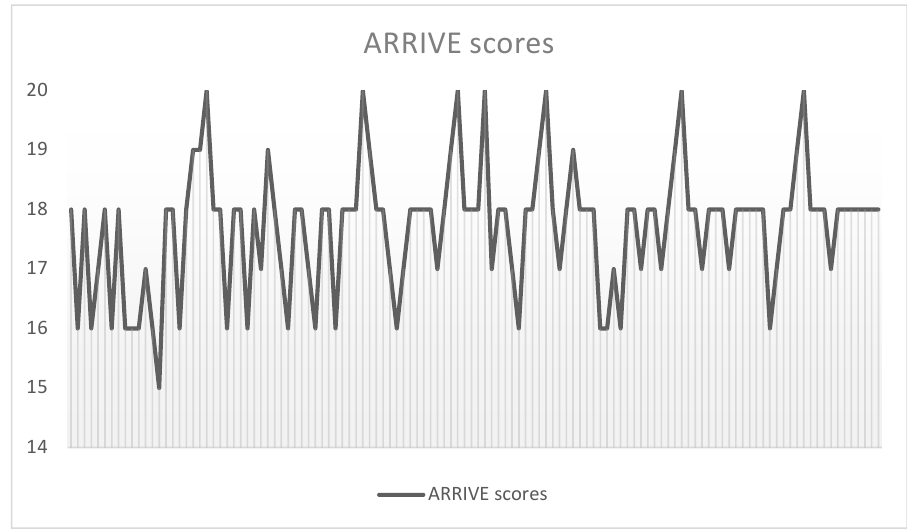
Figure 1. ARRIVE scores breakdown of included studies.